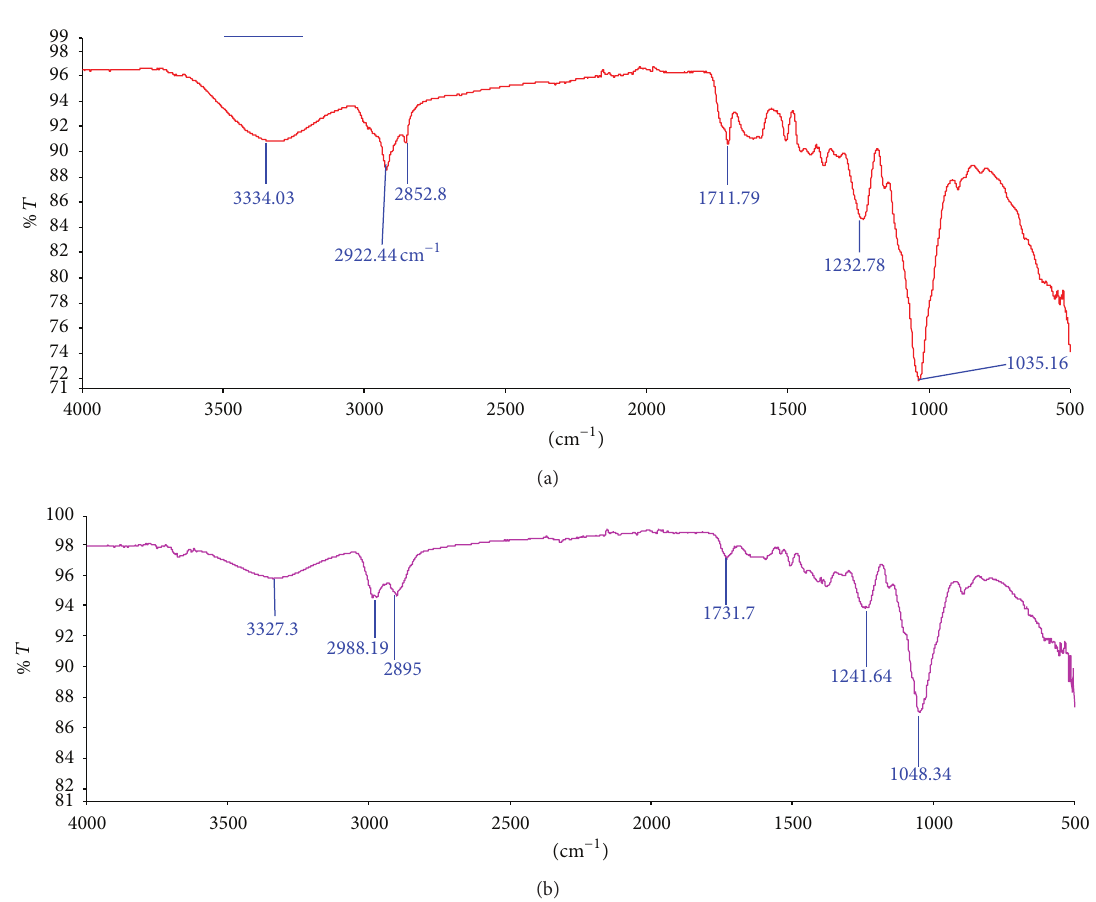
Figure 4: Unnormalized spectra of MNS (a) before metal sorption and (b) after metal sorption from water